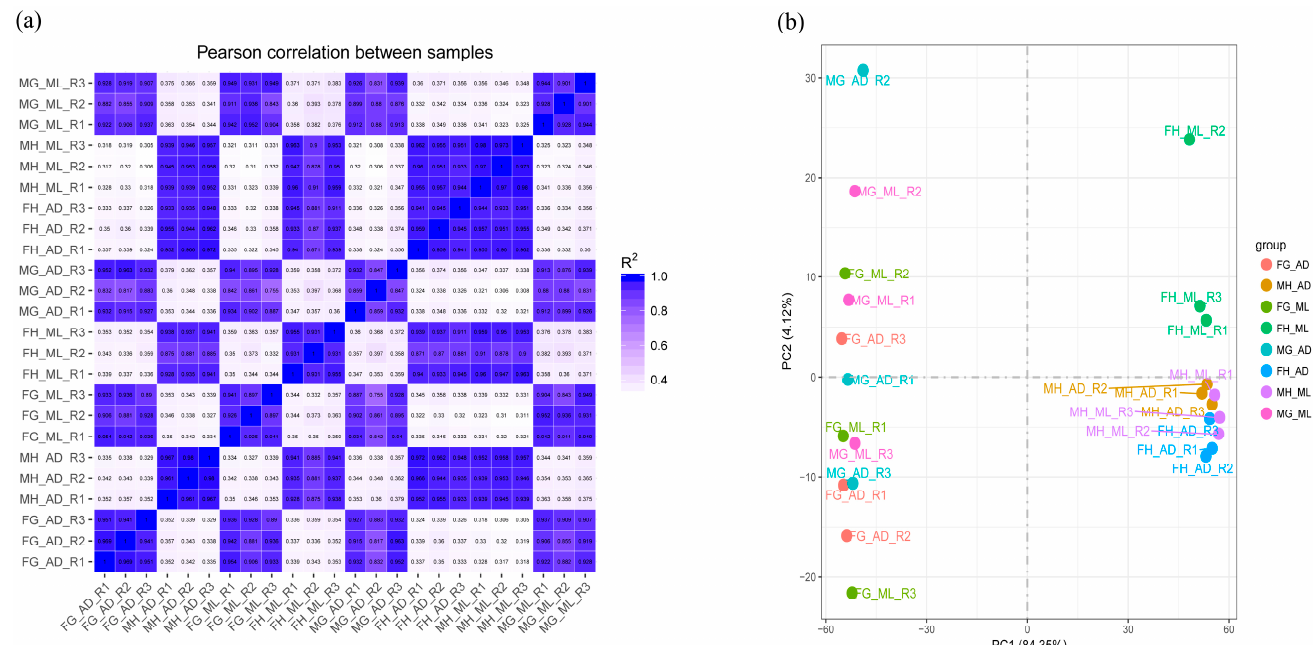
Figure 1. Correlation analysis and PCA. Correlation analysis displayed in ( a ) distance heatmap, with a legend representing Pearson correlation coefficient values between samples, and ( b ) principle component analysis based on data counts from RNA-Seqs prepared in triplicates for FG_AD, MH_AD, FG_ML, FH_ML, MG_AD, FH_AD, MH_ML, MG_ML.